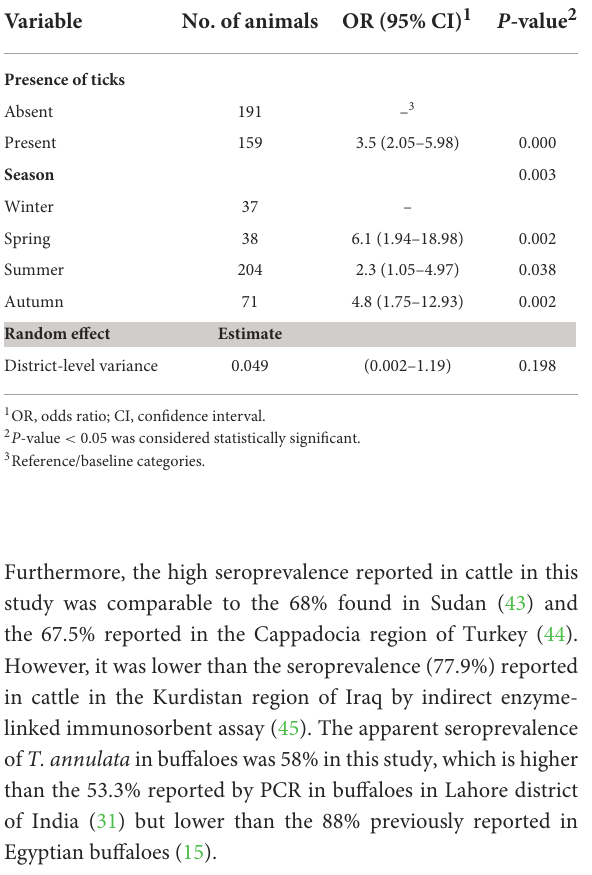
TABLE 3 Output of the final multivariable mixed-effects logistic regression model indicating variables associated with T. anaulata -seropositivity of cattle and buffaloes raised under the smallholder–production system in five districts of the Sharkia governorate,